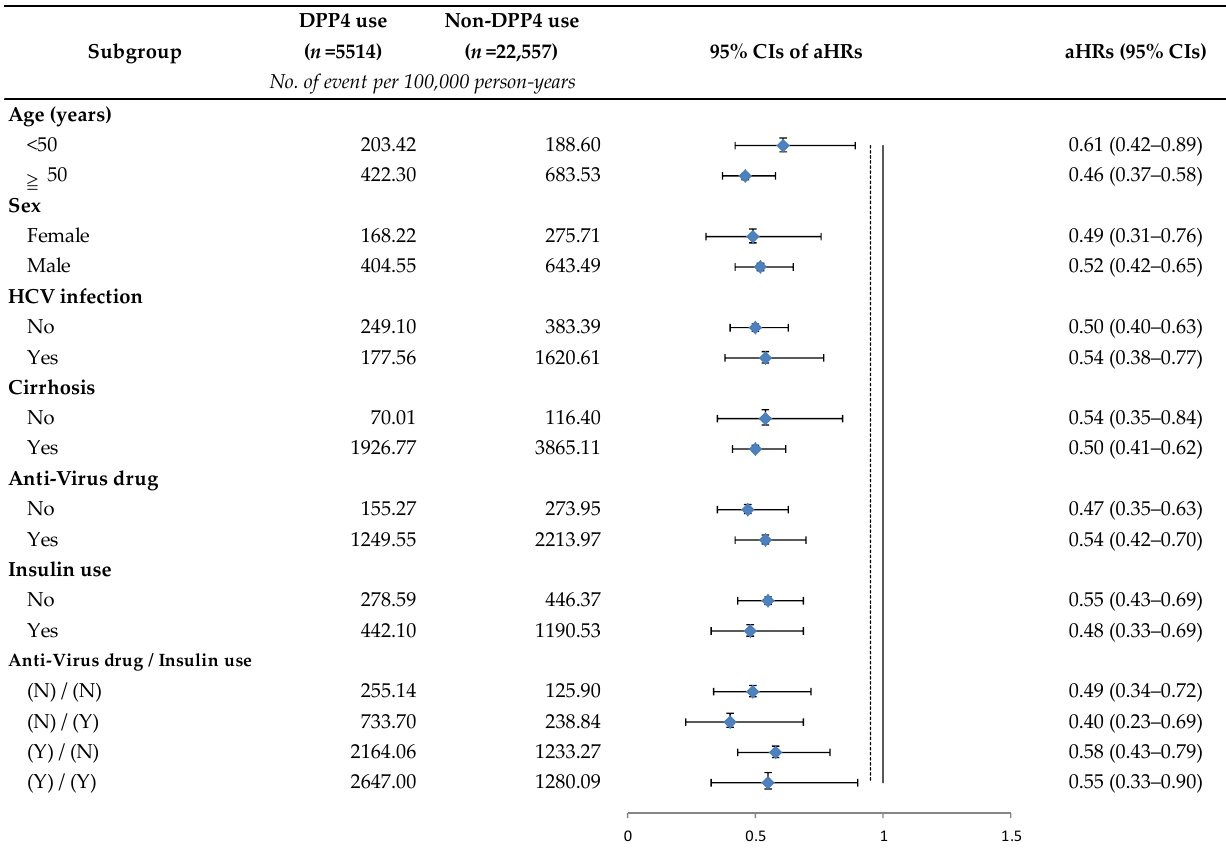
Figure 3. Subgroup analysis of DPP-4 inhibitors use for the reduced risk of hepatocellular carcinoma. Stratified by one of the following parameters and adjusted for the remaining of the following parameters: age, sex, chronic HCV infection, cirrhosis, anti-virus drug use, and insulin use. Abbreviations: HCV, hepatitis C virus; aHRs, adjusted hazard ratios; CIs, confidence intervals.